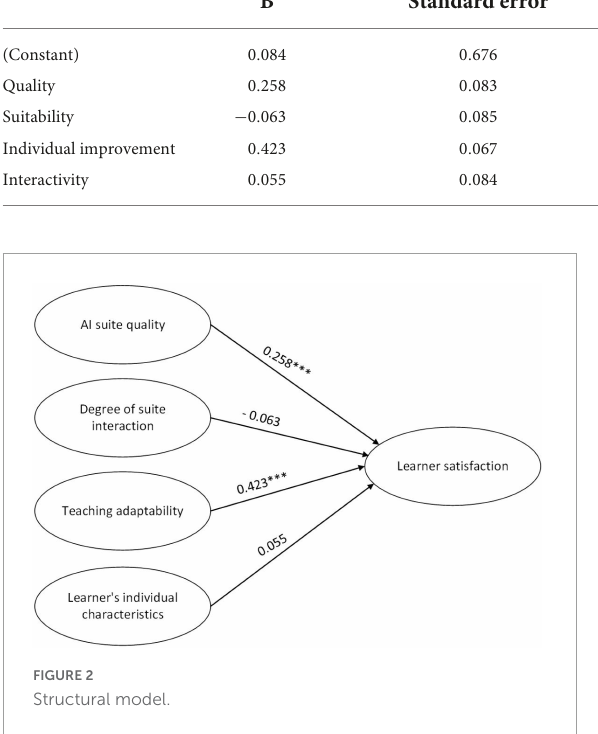
FIGURE2 Structural